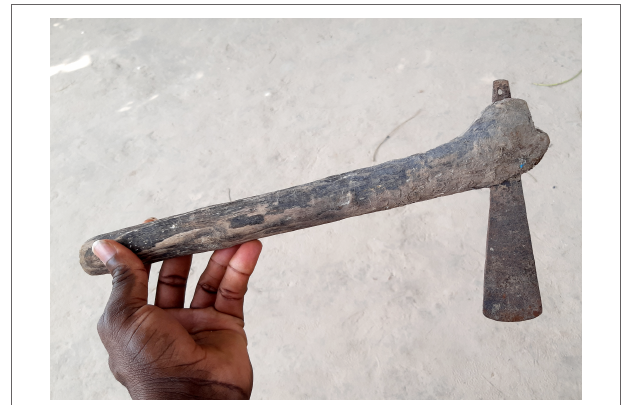
FIGURE 7 | Specialized mini axe (hatchet) used for harvesting oysters from mangrove roots without cutting the mangroves. [Data source: Image captured by authors for this